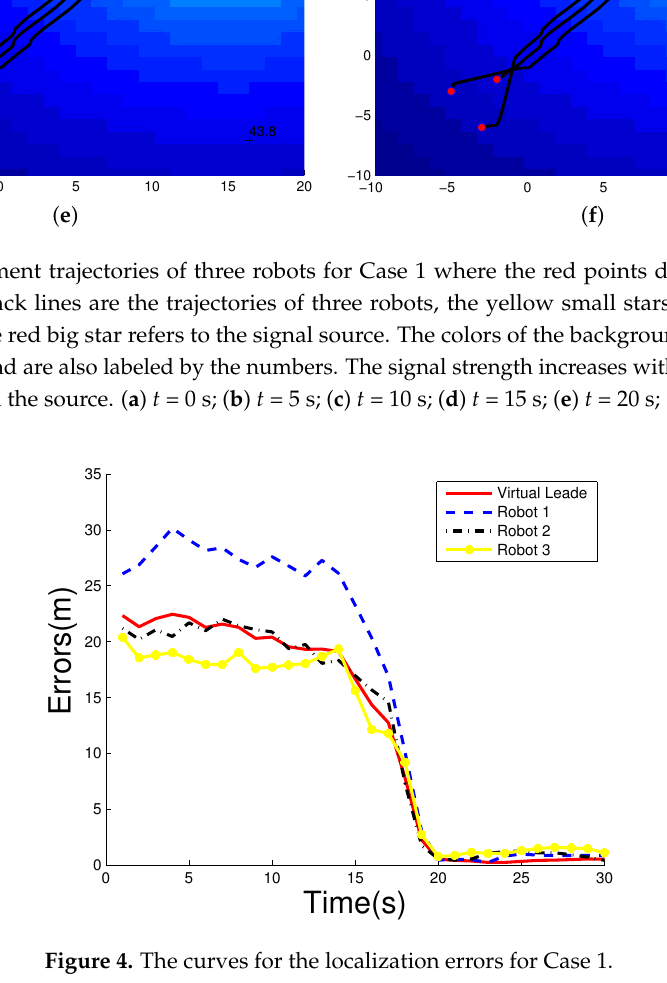
Figure 4. The curves for the localization errors for Case